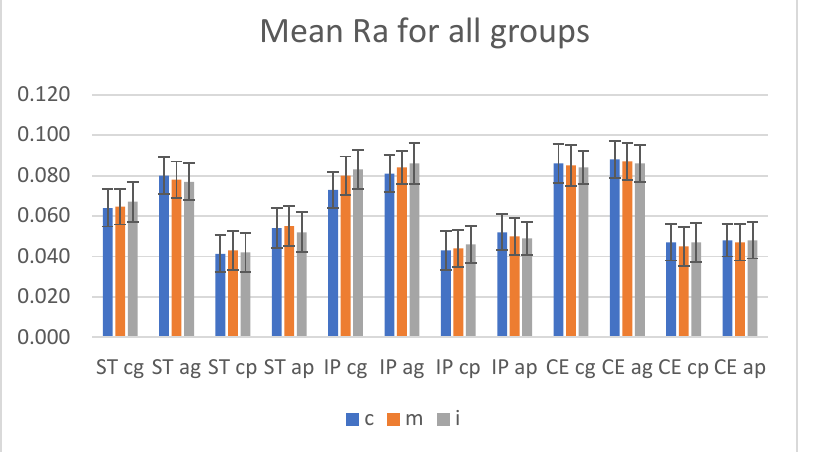
Figure 2. Mean Ra values (arithmetic average surface roughness) with SD (standard deviation), before and after aging for all groups. ST = STML, IP = IPS e.maxZirCAD CEREC/in Lab MT Multi, CE = CeramillZolidfx ML. cg = control glazed, cp = control polished, ag = aged glazed, ap = aged polished, c = cervical, m = medium, i = incisal.